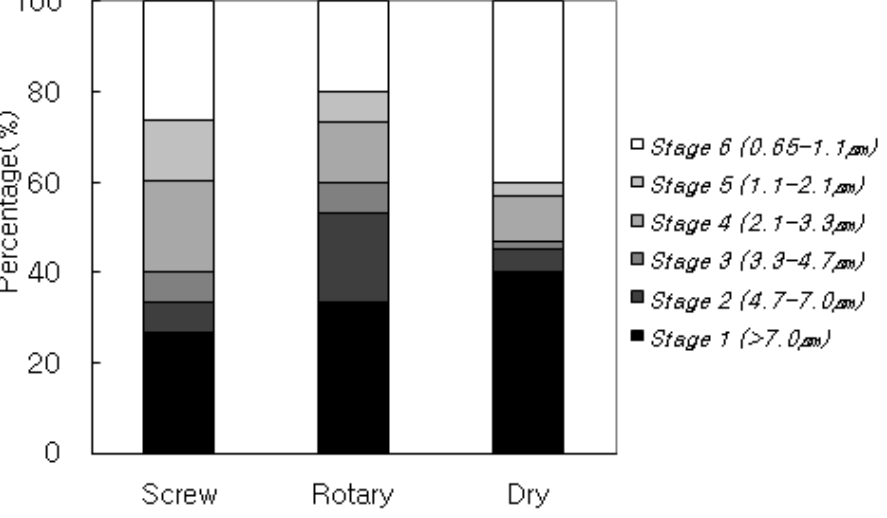
Figure 3. Size distribution characteristics of airborne fungi in livestock manure composting plants.